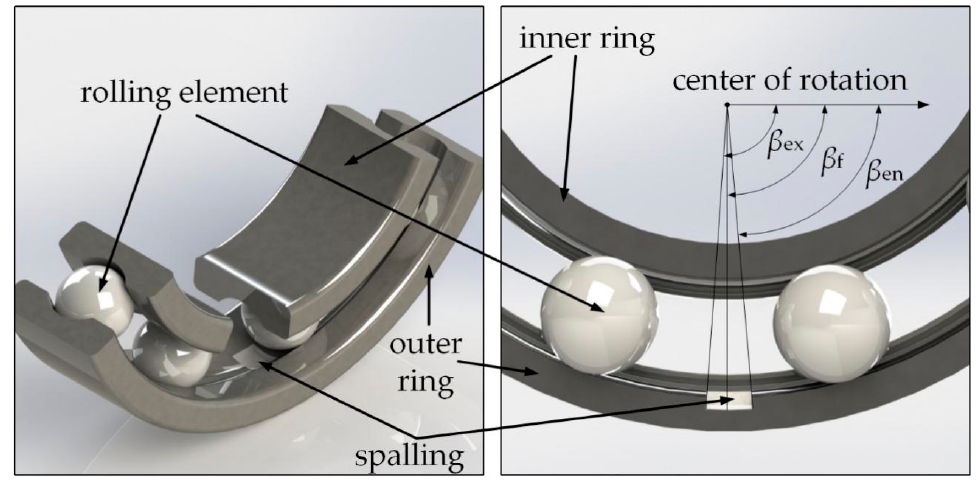
Figure 2. Angular diagram of the position of the rolling elements passing through the bearing outer ring spalling.